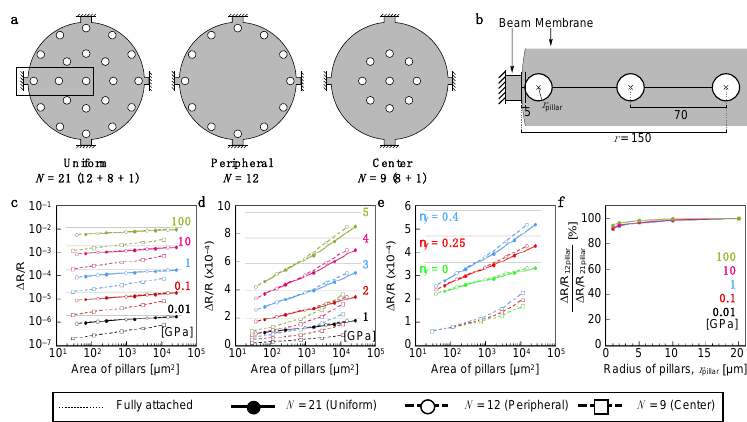
Figure 2. Dependence of the relative resistance change ∆ R / R | total on the area of the interfacial attachments calculated by FEA. ( a ) Configuration of pillars as a model of interfacial attachment. ( Left ) Uniformly distributed model, number of pillars, N = 21; ( center ) Peripheral position model, N = 12; and ( right ) Center-distributed model, N = 9. ( b ) Magnified configuration of pillars shown in the rectangular in ( a ). Numbers indicate the dimensions in µ m. The radii of pillars ( r pillar ) are varied from 1 µ m to 20 µ m. ( c,d ) Dependence of the total resistance change ( ∆ R / R | total ) on Young’s moduli as a function of the area of pillars. The Young’s moduli ( E f ) are varied from 0.01 GPa to100 GPa ( c ) and from 1 GPa to 5 GPa ( d ). Poisson’s ratio of the coating film ( ν f ) is set at 0.4 and r pillar is varied as follows: 1, 2, 5, 10, 20 µ m. ( e ) Dependence of the total resistance change ( ∆ R / R | total ) on Poisson’s ratios as a function of the area of pillars. The Young’s modulus of coating film ( E f ) is set at 3.0 GPa, which is similar to that of PMMA. All dotted lines in ( c ), ( d ) and ( e ) are ∆ R / R | total of a conventional full attachment model without any pillars. ( f ) The comparison between the uniformly distributed model ( N = 21) and the peripheral position model ( N =